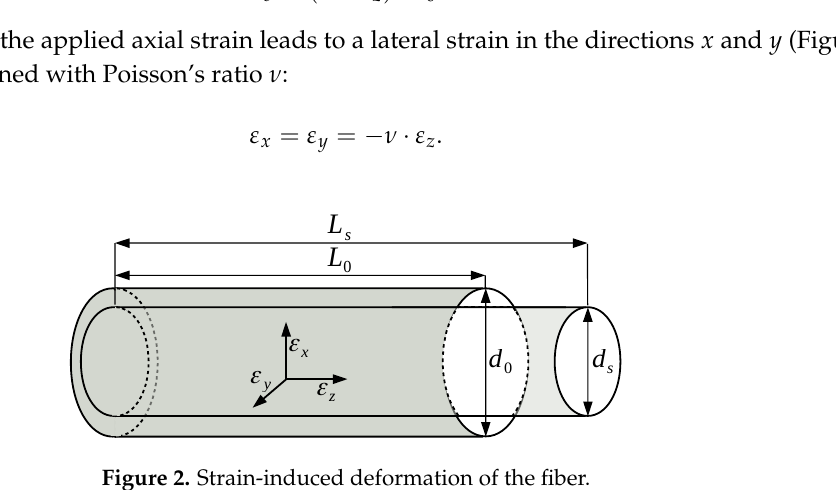
Figure 2. Strain-induced deformation of the